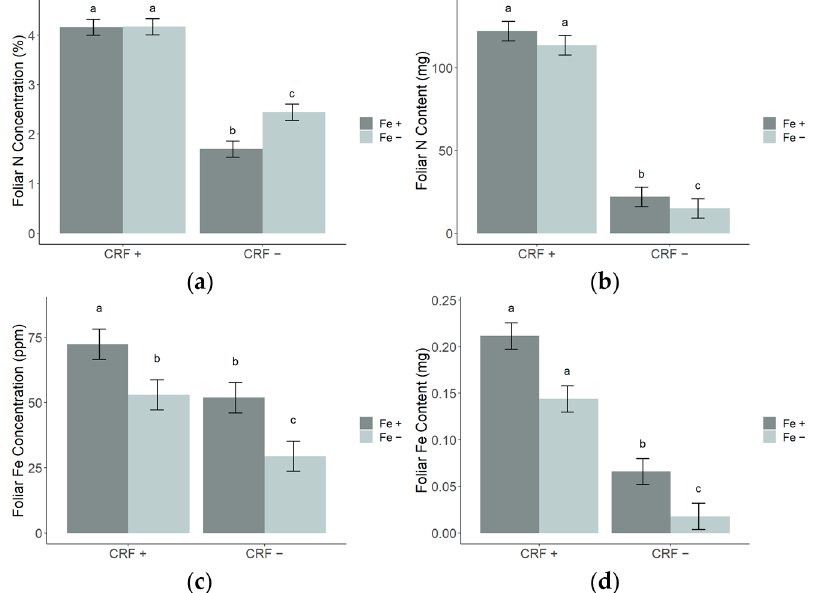
Figure 4. The mean ( ± SE) foliar nitrogen (N) (concentration (%) and content (mg)) and foliar iron (Fe) (concentration (ppm) and content (mg)) values of S. paniculatum seedlings. ( a ) The N concentration (%), ( b ) N content (mg), and ( d ) Fe content was increased in all plants that received CRF. The chelated iron had a significant effect when applied without CRF, decreasing the N concentration, but increasing the N content and Fe content. ( c ) The foliar Fe concentration was the same in treatments that only received CRF and treatments that only received chelated iron. Different letters indicate significant differences among treatments ( α = 0.05). Fe+ = chelated Fe applied; Fe − = control; CRF+ = CRF applied; CRF − = control.